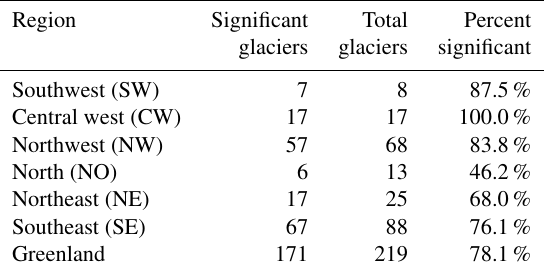
Table 1. Regional breakdown of the number and percentage of glaciers with significant ( p < 0.05) terminus-position seasonality.